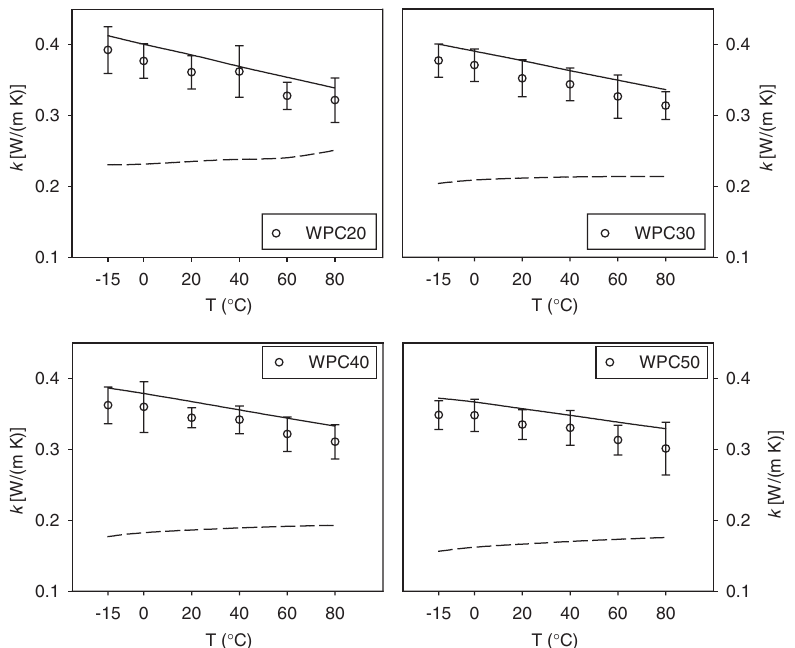
Figure 8 Thermal conductivity of the WPCs (mean values with 95% confidence intervals are reported). The continuous and dashed lines are the parallel and series conduction models,